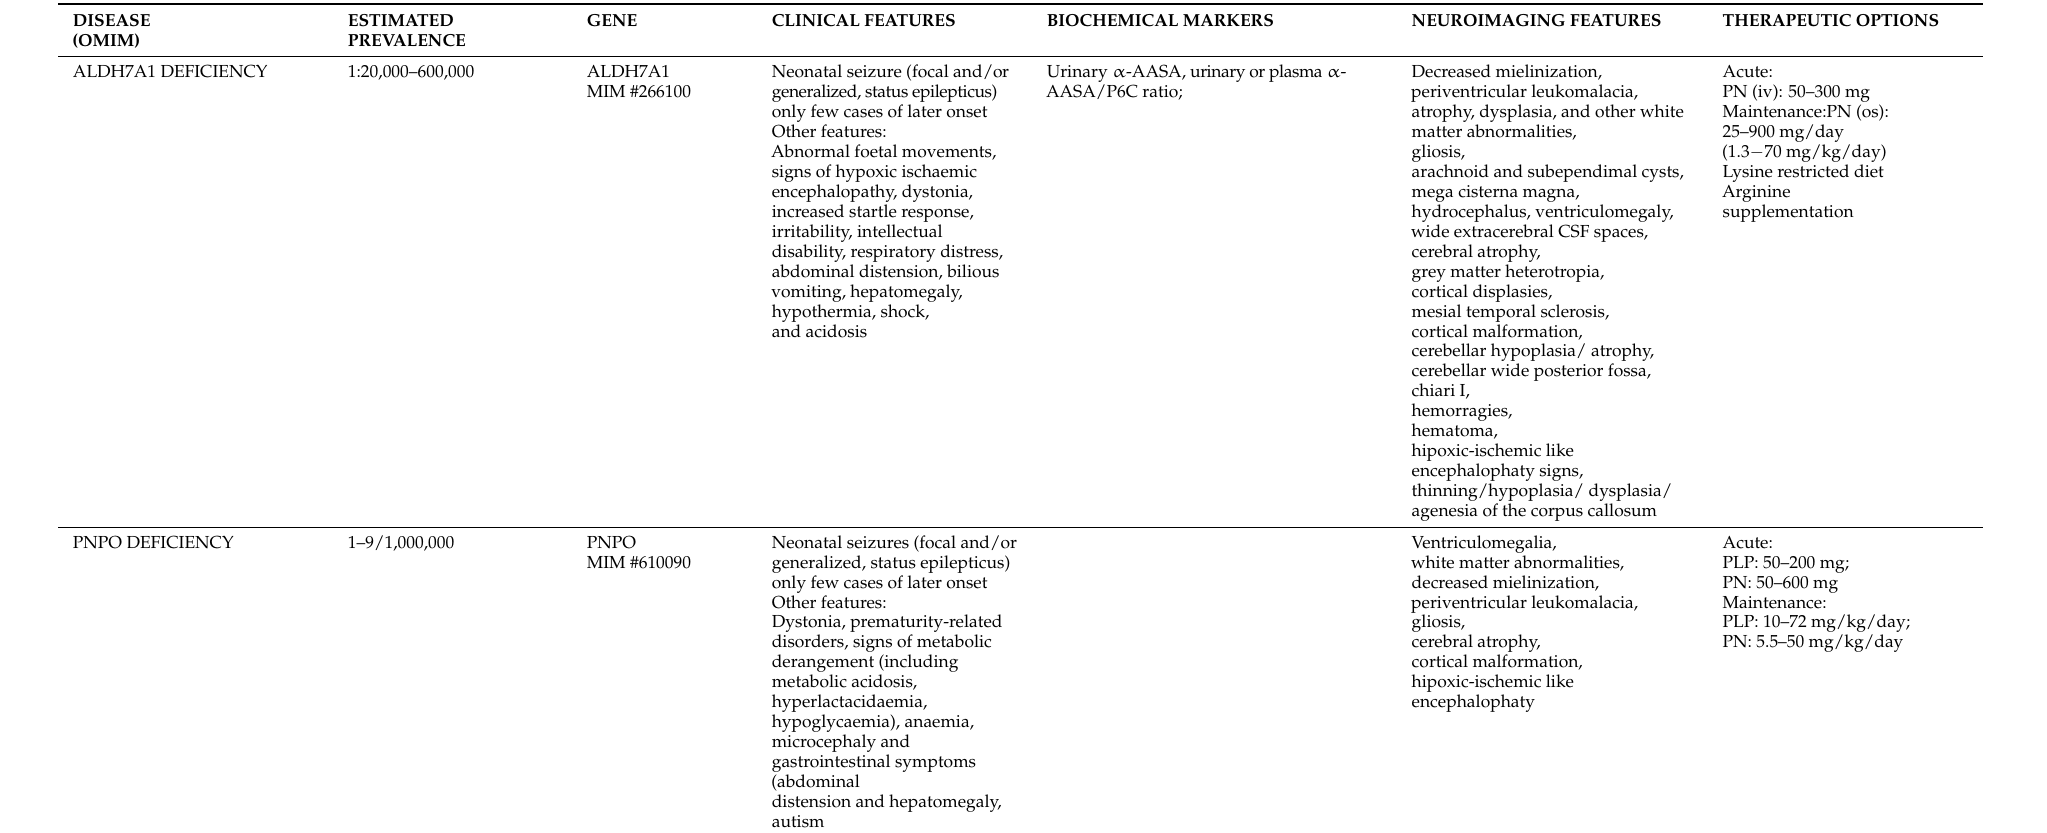
Table 1. Epidemiological, clinical, biochemical, genetic, and neuroimaging features of vitamin B6-dependent